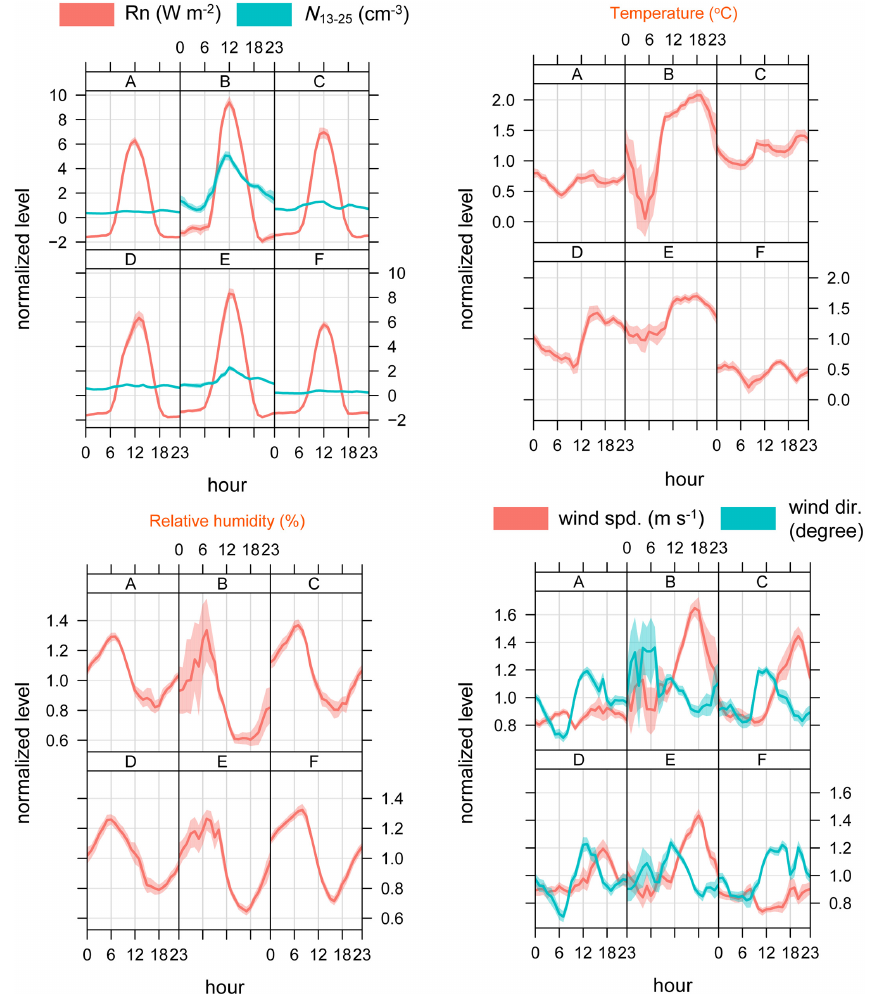
Figure 12. Normalized diurnal variations of net radiation ( R n ), N 13 − 25 , temperature, relative humidity, and wind speed and direction for each cluster during the campaign. The shading shows the estimated 95% confidence